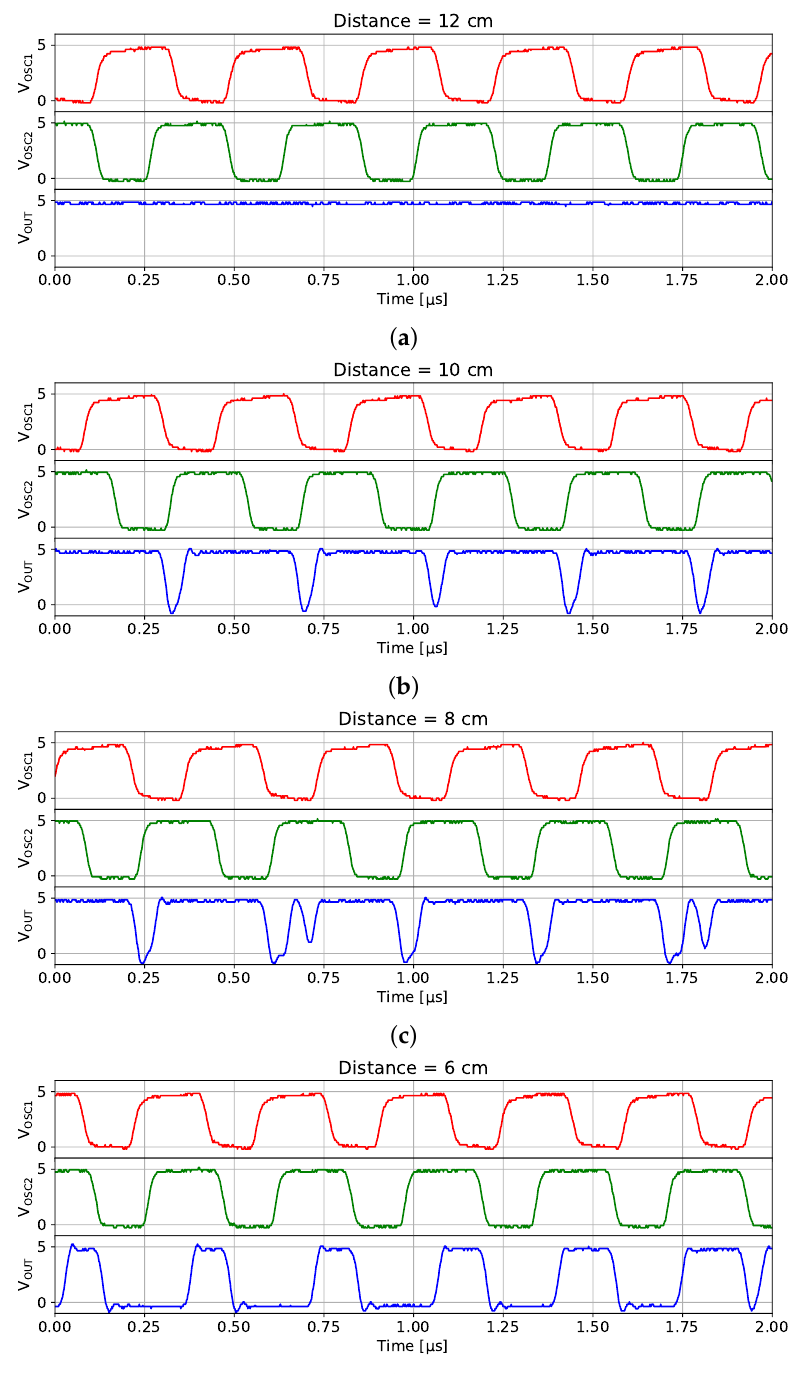
Figure 3. Measured waveforms at the inputs and output of the mixing stage at different distances: ( a ) 12 cm. ( b ) 10 cm. ( c ) 8 cm. ( b ) 10 cm. ( d ) 6